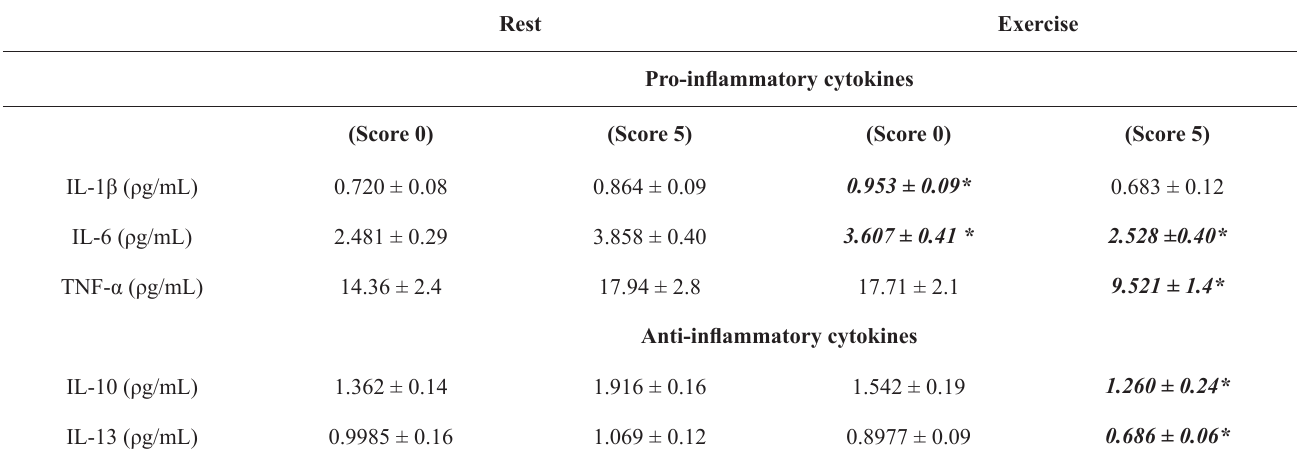
Table 2 - Mean values of pro and anti-inflammatory markers at rest and after exercise. Data expressed as mean ± SD. P-values or significance levels * (p <0.05) for IL-6, IL-10, IL-13, and TNF-α (I can’t take it anymore) and IL-1β and IL-6 (I don’t feel anything) vs. baseline,